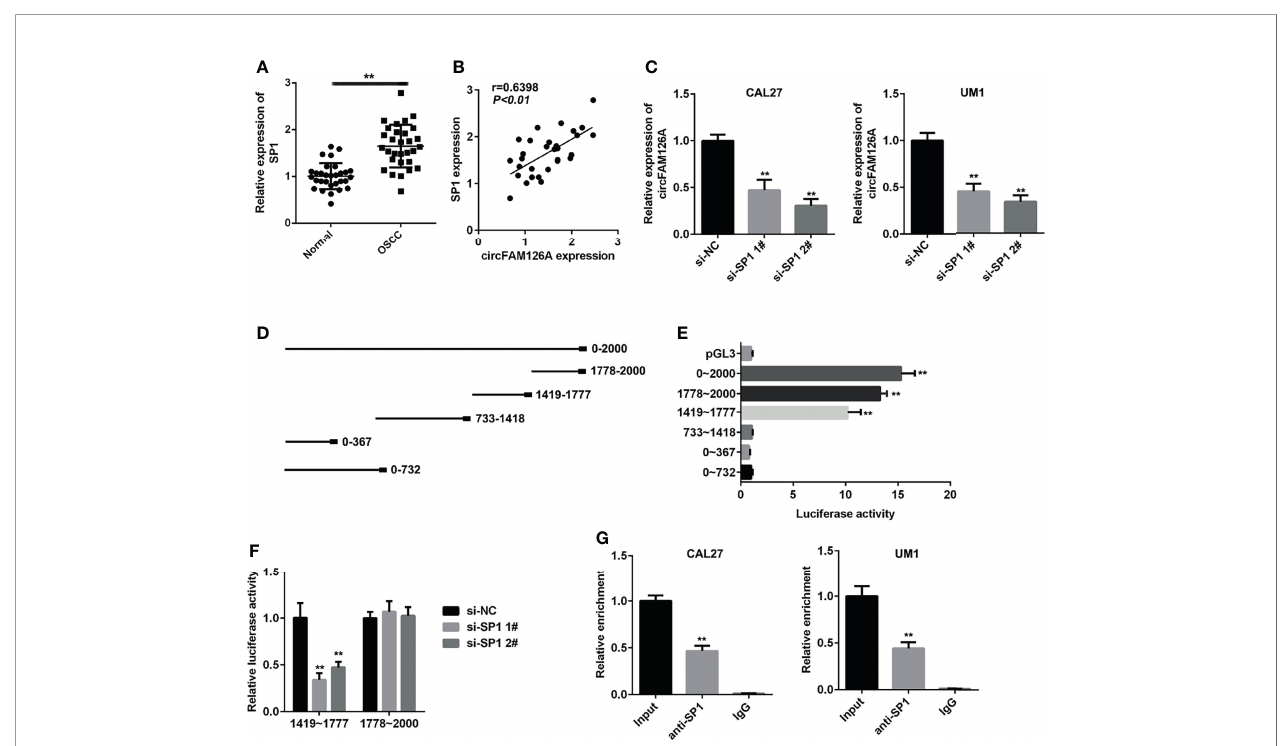
FIGURE 2 | SP1 transcriptionally activates circFAM126A in OSCC. (A) mRNA expression of SP1 in OSCC patients measured using qRT-PCR. (B) Correlation analysis of expression levels of SP1 and circFAM126A in OSCC patients. (C) Expression of circFAM126A detected by qRT-PCR. (D) Serial truncations of circFAM126A promoter inserted into pGL3 vector. (E, F) Interaction between SP1 and circFAM126A veri fi ed by luciferase assay. (G) Interaction between SP1 and circFAM126A veri fi ed by ChIP assay. ** P <0.01.